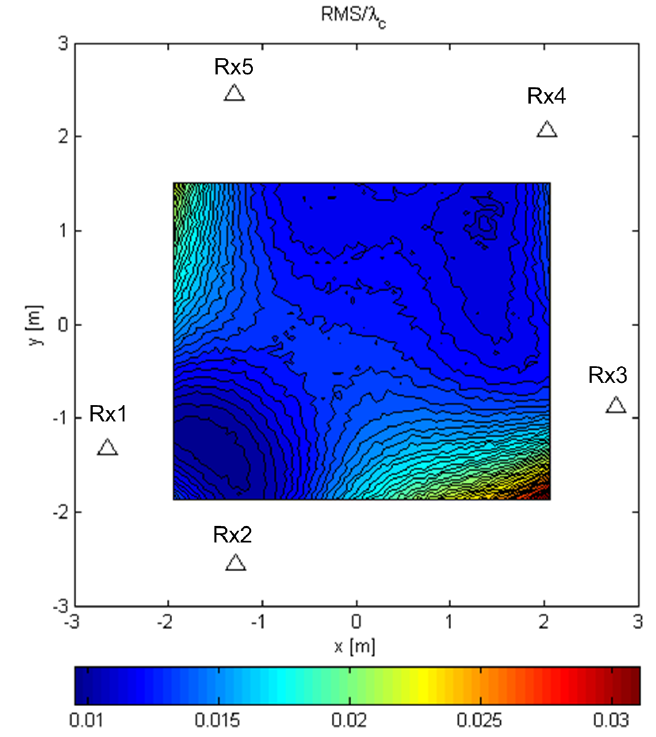
Figure 8. RMSE/ λ c of the ML-US for random Gaussian signals.